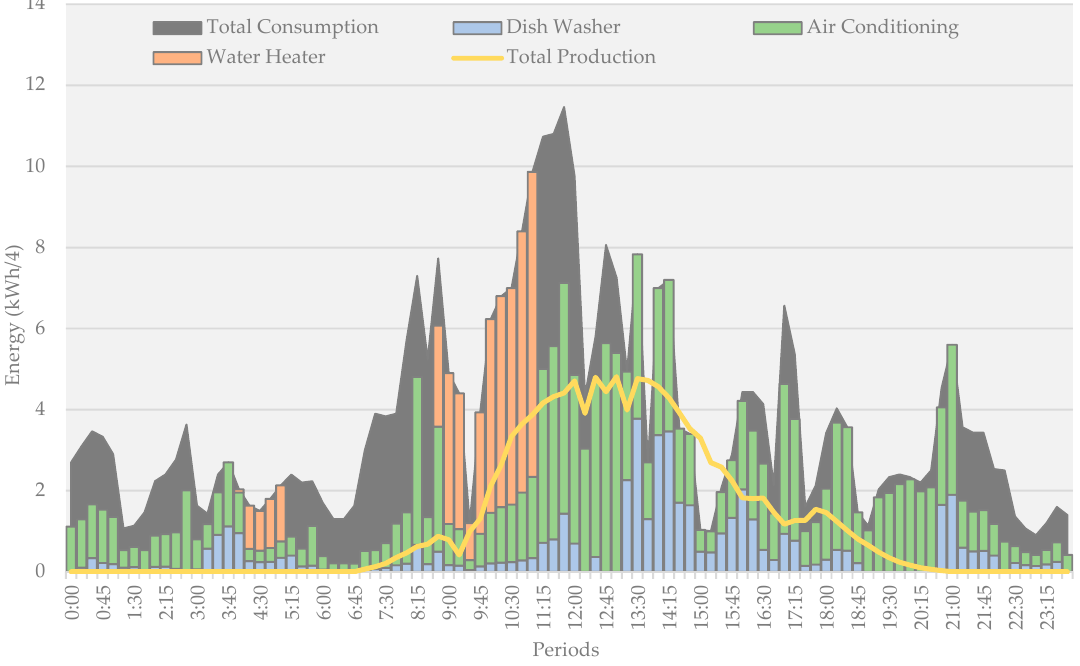
Figure 3. Disaggregated consumption by appliance and photovoltaic (PV) generation.